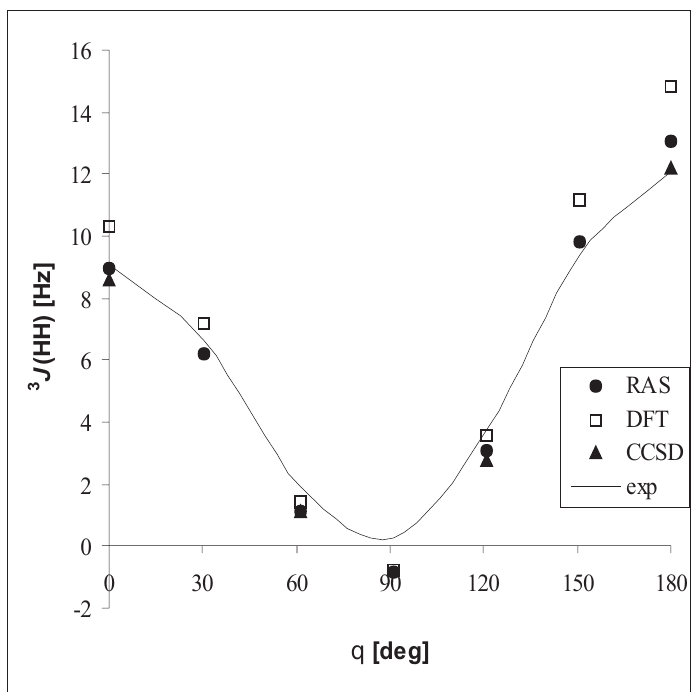
Figure 3: Comparison of the Karplus curve for methanol obtained at the DFT level the MCSCF level (RAS-0 results from Ref. [22]) and the CCSD level with an empirical curve